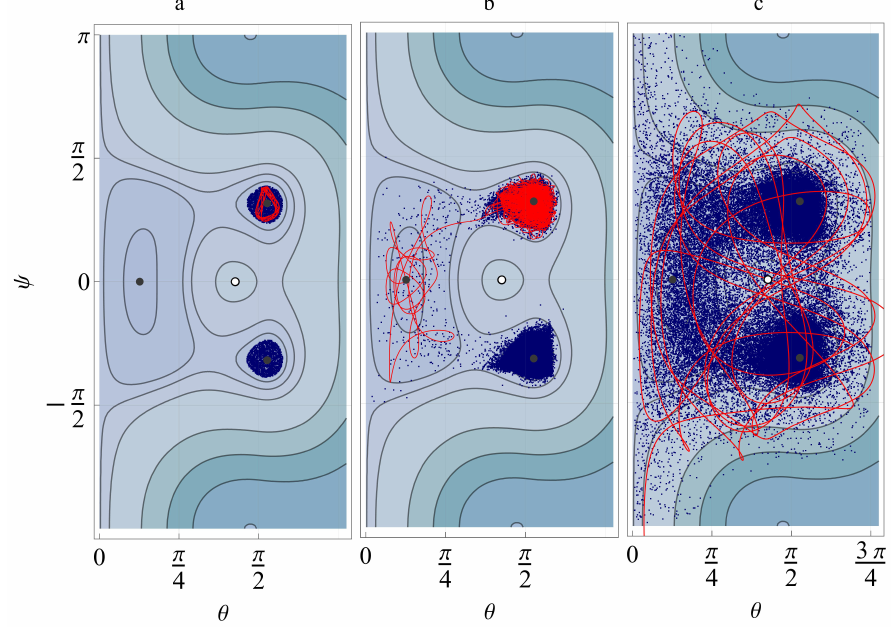
Figure 9. Poincaré sections ( h = 700 km, β = 20); ( a ): ε = 0, ( b ): ε = 0.58, ( c ): ε = 1.35. Red lines: typical phase